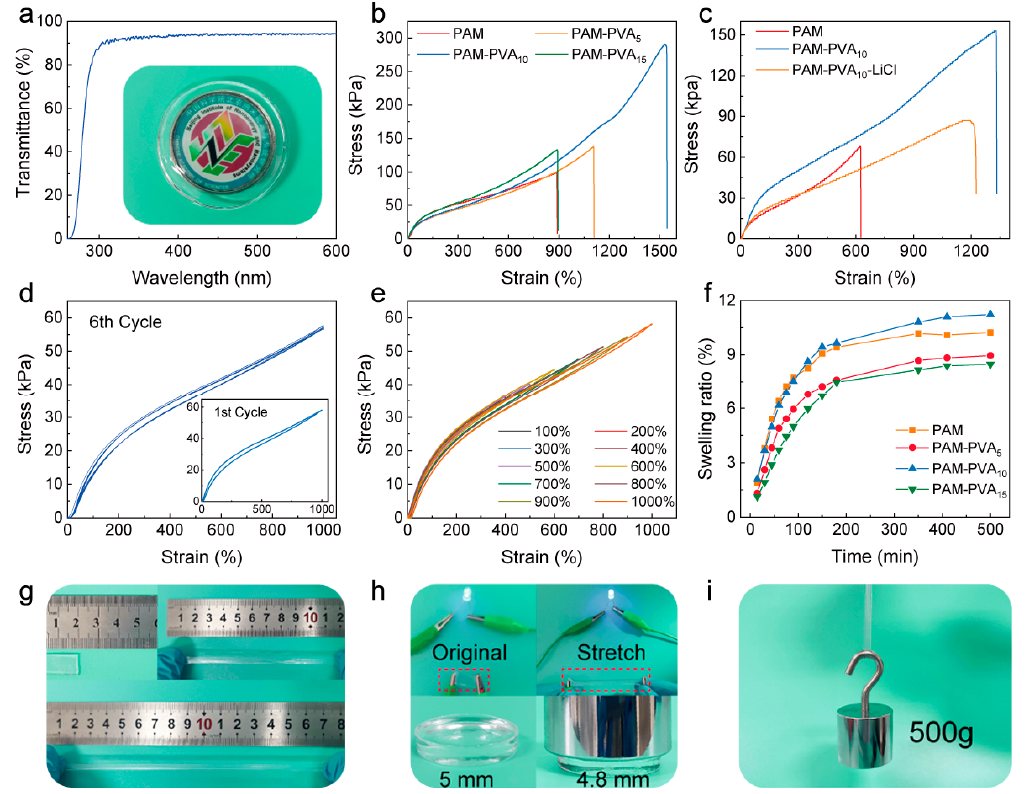
Figure 2. Tensile performances of the hydrogel with different polymer contents. ( a ) Transmittance curves of hydrogels with photos showing the transparency of the hydrogel. ( b ) Tensile curves of hydrogels with different components. ( c ) Tensile curves of hydrogels. ( d ) Loading–unloading cycles of PAM-PVA 10 hydrogels for six consecutive cycles at a strain value of 1000%. ( e ) Tensile loading– unloading curves for PAM-PVA 10 hydrogel at strain from 100–1000%. ( f ) Swelling ratio of the hy- drogels as a function of time. ( g ) Photograph showing the high stretchability of the hydrogel. ( h ) Photographs of the conductivity and compressibility of hydrogels. ( i ) Photograph of PAM-PVA 10 ionic hydrogel with 500 g weight.